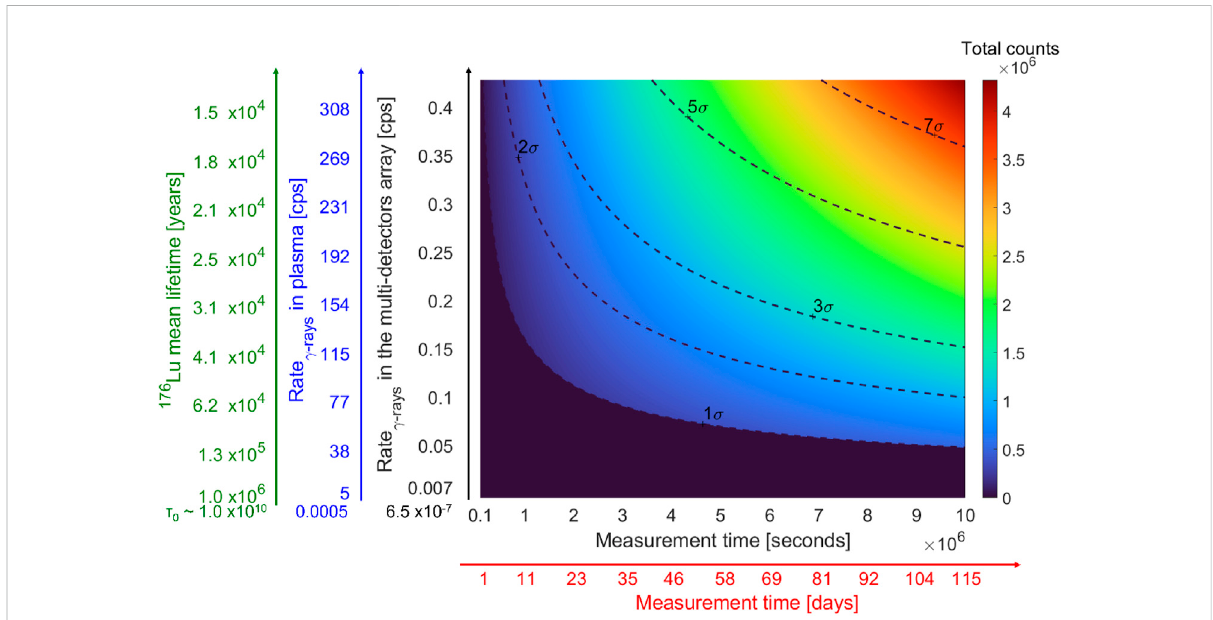
FIGURE 10 Total counts of gamma-rays emitted (pseudo-colors scale) and iso-signi fi cance contours (dashed lines) for different 176 Lu isotope lifetimes (green vertical axis) as a function of the measurement lifetime. Blue and black vertical scales show the predicted decay rate in plasma and the counting rate measured in the array associated to the different isotope lifetime.